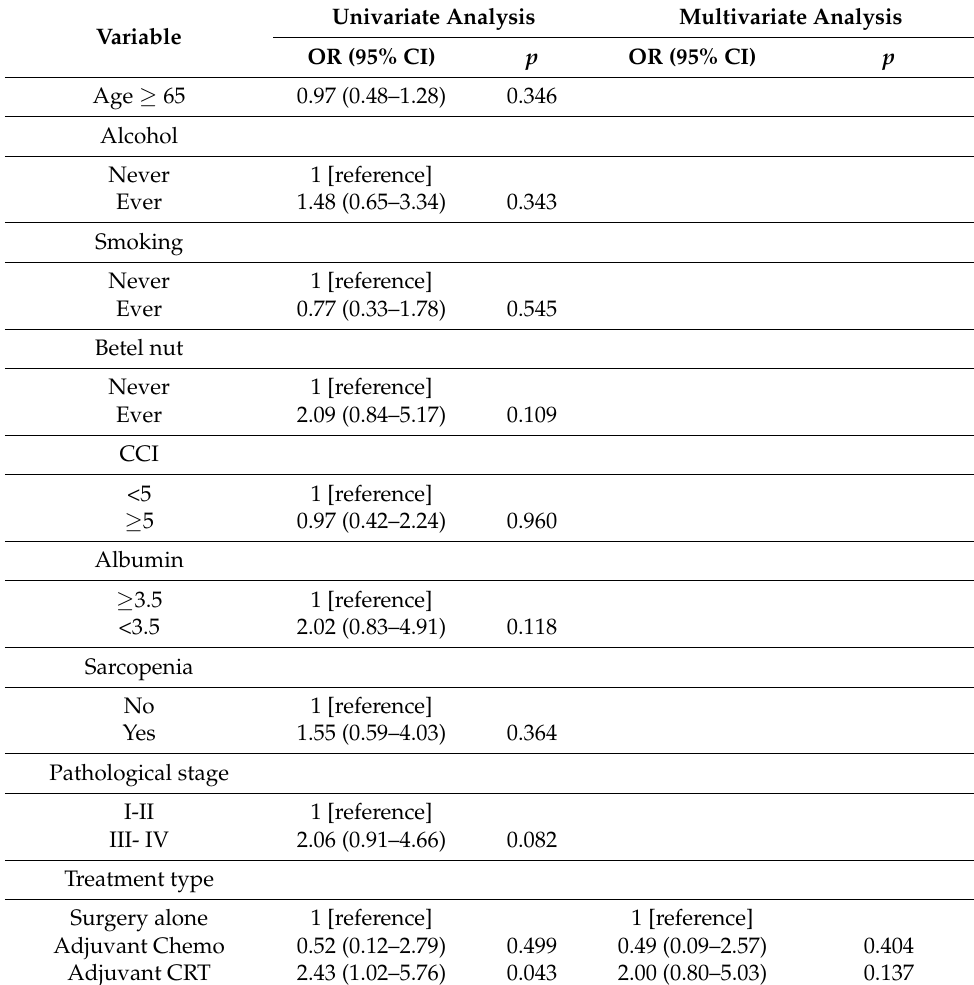
Figure 1. Receiver operating characteristic curves for determining the optimal cutoff value of preoperative systemic inflammatory markers for bloodstream infection. ( A ) Lymphocyte-to-monocyte ratio, ( B ) neutrophil-to-lymphocyte ratio, and ( C ) platelet-to-lymphocyte ratio. Table 3. Logistic regression analysis for bloodstream infection.